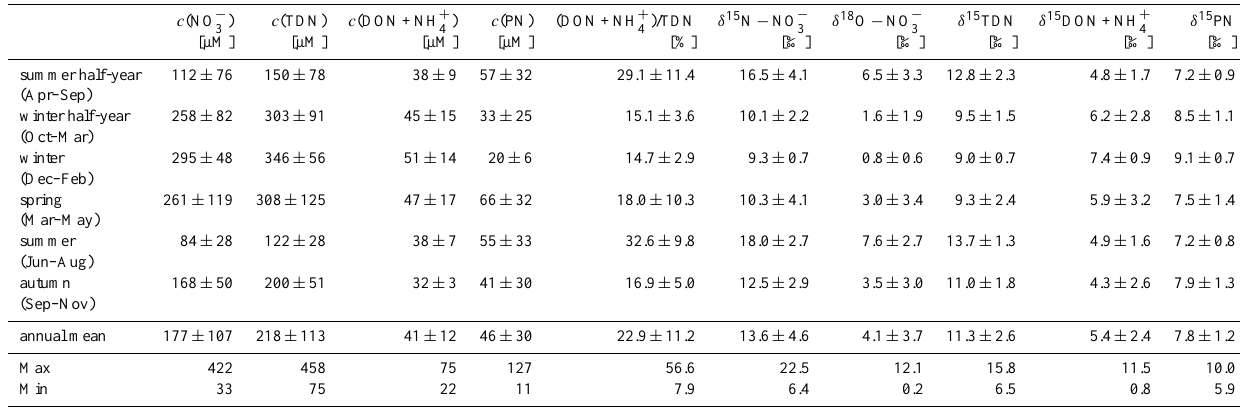
Table 2. Annual and seasonal mean concentrations and mean isotope values of nitrate, TDN, DON+NH + mean DON+NH + ratio in the Elbe River at the weir of Geesthacht, June 2005–December 2007. 4 c (NO − 3